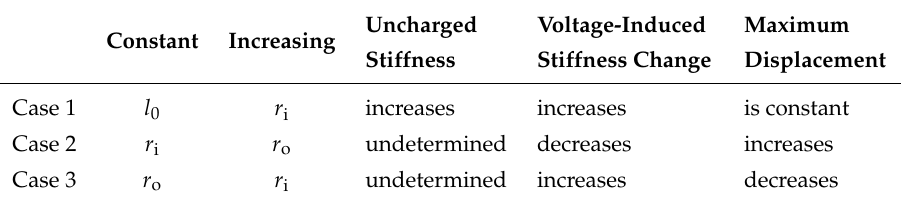
Table 2. How module dimensions affect the performance of cone-diaphragm